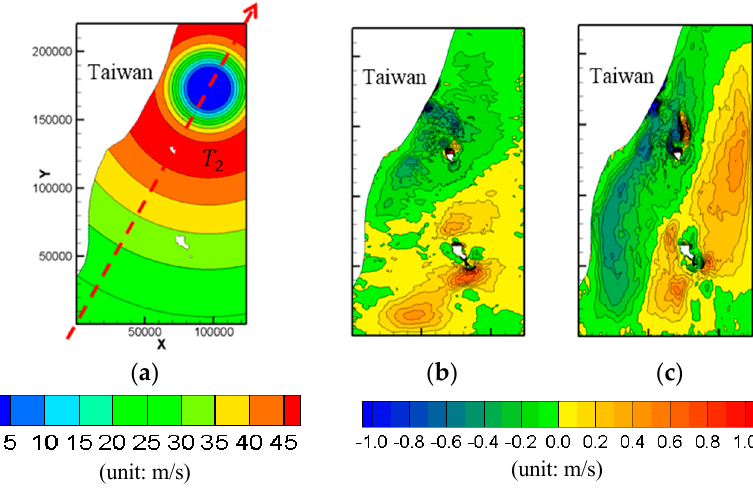
Figure 11. Contours of ( a ) W 10 , “net” ( b ) u -, and ( c ) v -contours of (unit: m/s) SN typhoon with moving speed W T = 5.0 m/s at T 0 – T 2 three time instances indicated by the three vertical lines of Figure 16b. Figure 12 plots the wind field as well as wind vectors (red) and flow (blue) vectors along Q 0 Q 1 at T 0 – T 2 three time instances. The flow field and downstream island wakes are significantly affected by the northeastward typhoon. Kuroshio currents increase as the typhoon approaches and decrease as the typhoon passes away.